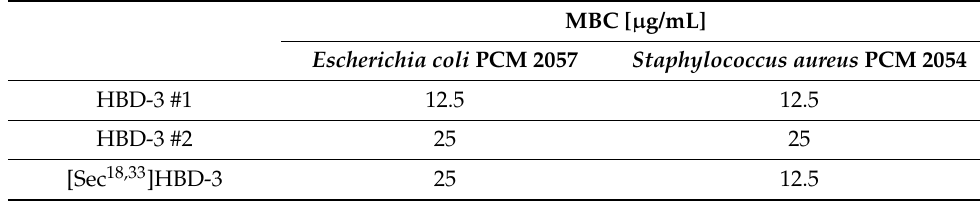
Table 2. Antimicrobial activity of the synthesized peptides against E. coli and S. aureus